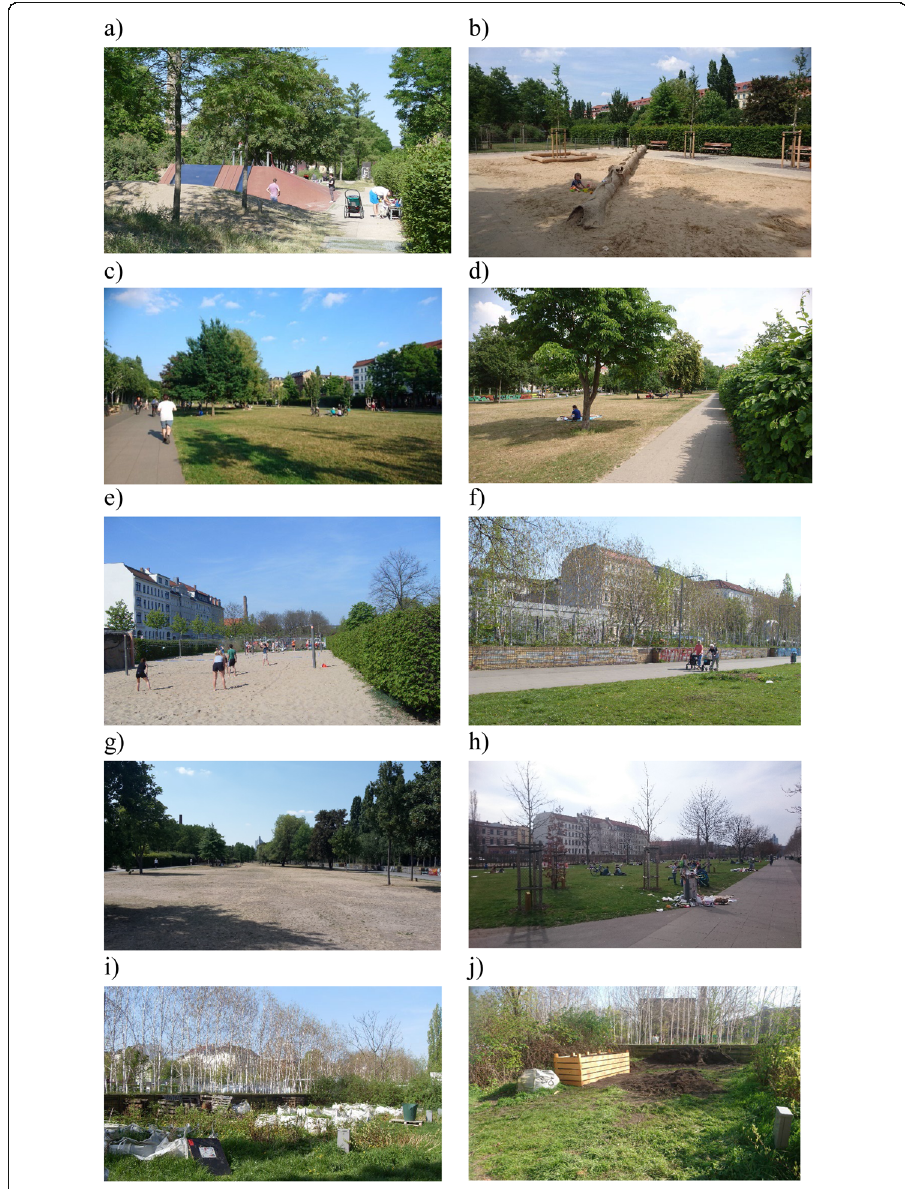
Fig. 2 Expressions from Lene-Voigt Park – a former railway brownfield in the city of Leipzig. Legend: use. a and b Children using the park with play areas in partially separated areas. For the children slides see also https://www.leipzig.de/detailansicht-adresse/spielplatz-lene-voigt-park-rutschplatz/. c and d main area of the park for multi-purpose. e Beach-volley ball field. f Elderly people using the sealed parts without barriers. g Lawn are under heat stress during summer 2018. h Waste problem in the park. i Neglected lots for urban gardening in 2018. j New urban gardening activities and experiments in April 2019. All pictures taken by GreenEquityHEALTH group members